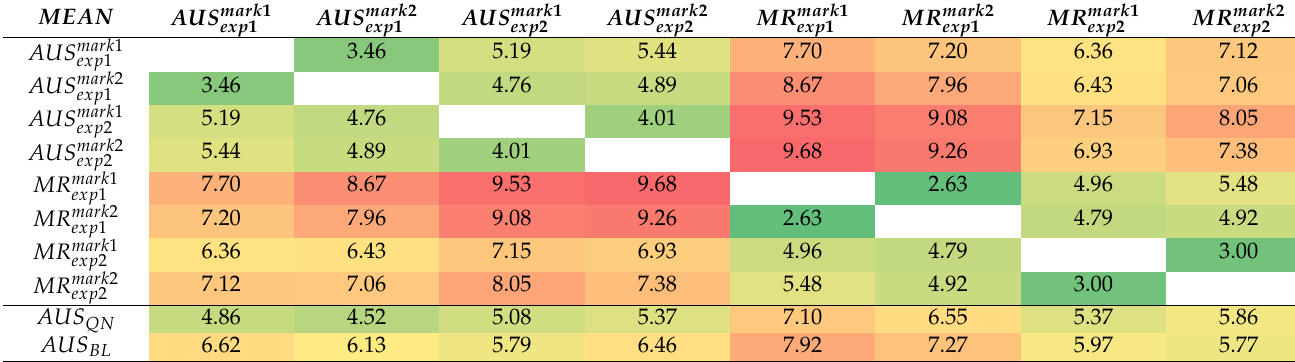
Table 1. Top part shows intra-expert and inter-expert MAVD values in cm 3 for AUS and MR modalities and is symmetrical. The MAVD values between experts, our QDCNN system, and the baseline is shown in the bottom part. Green shows the smallest (best), and red shows the highest MAVD. See the text for the explanation of the column and row headings.